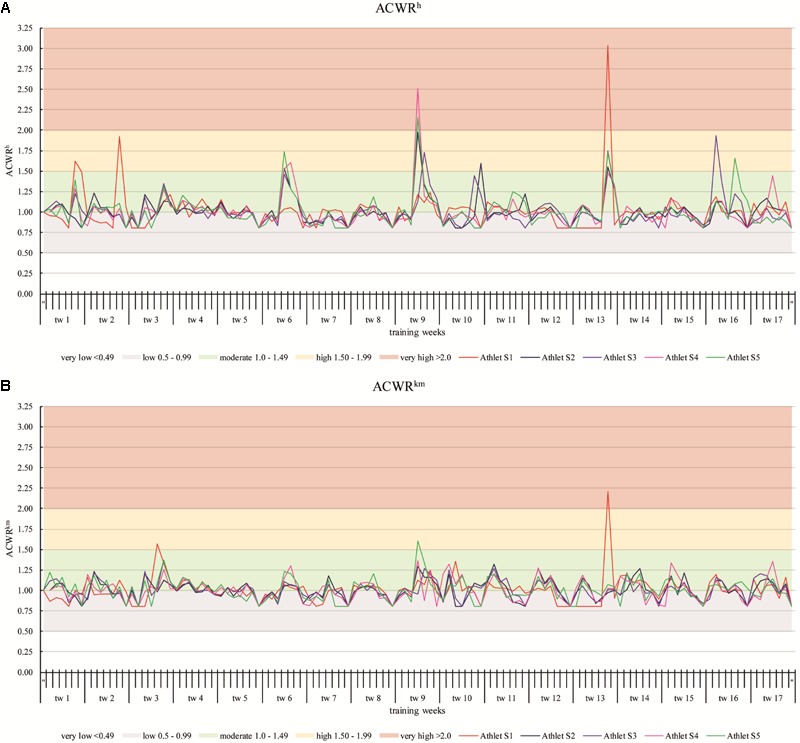
The acute:chronic workload-ratio over 17 training weeks of the athletes S1–S5 based on the sRPEh- (A) and the sRPEkm-values (B).